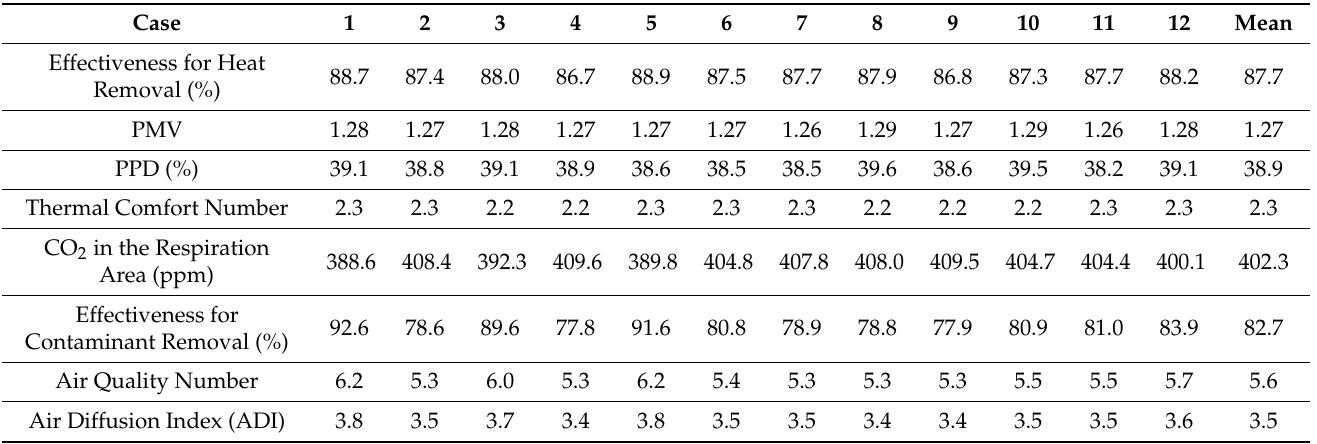
Table 8. ADI obtained for Case II (0.1167m 3 /s) at 16